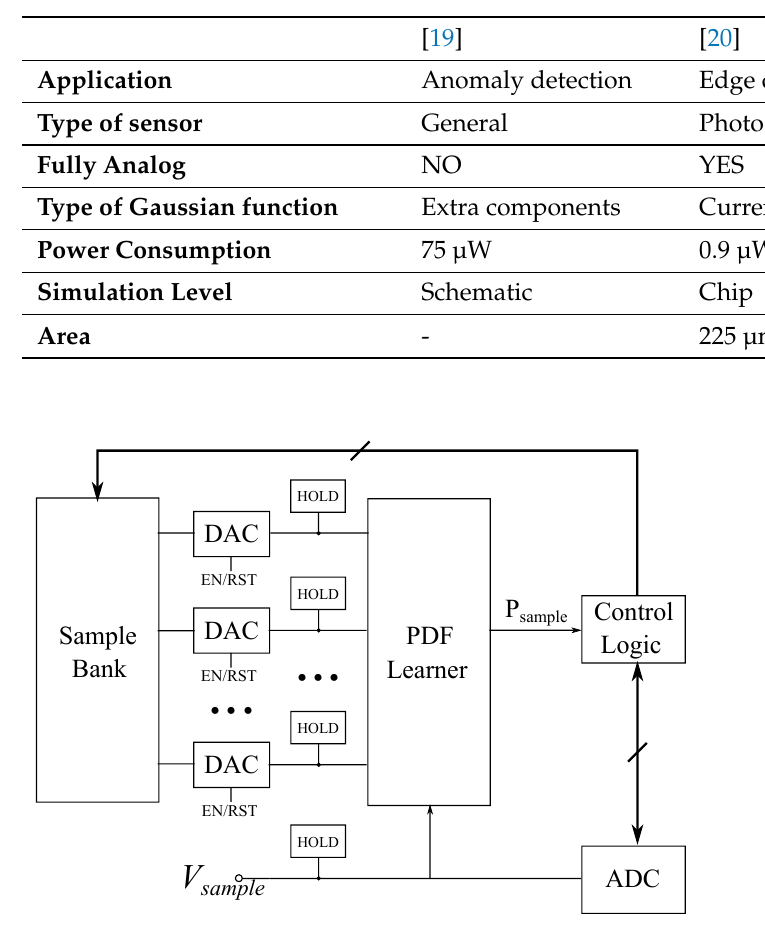
Figure 40. A mixed-mode anomaly detection